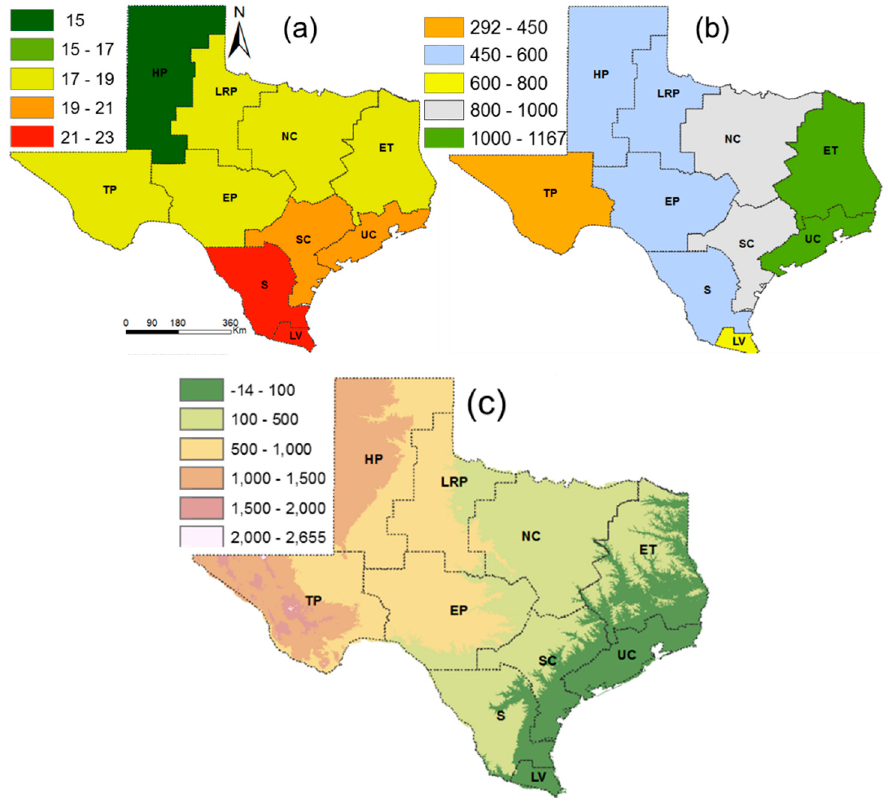
Figure 2. ( a ) Annual average Temperature (°C); ( b ) Annual average precipitation (mm); and ( c ) Elevation (m) across the state of Texas (2016 data).